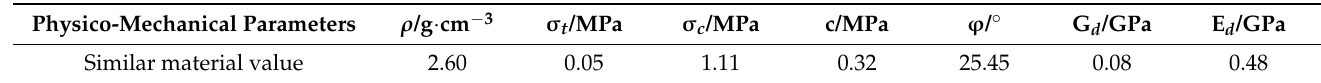
Table 7. Physico-mechanical parameters of model materials similar to the samples collected from the site.